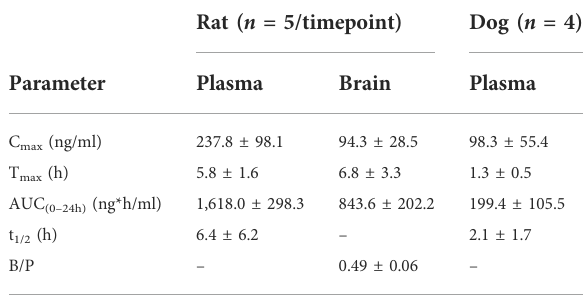
TABLE 2 Pharmacokinetic parameters after oral gavage of CPL500036 in a dose of 3 mg/kg in rats and 1.5 mg/kg in dogs ’ . Data are the mean ± SD.